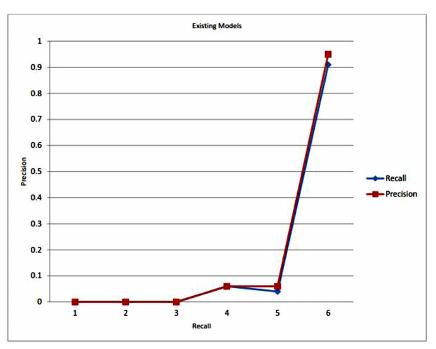
Table 3. Replaceability Outcomes